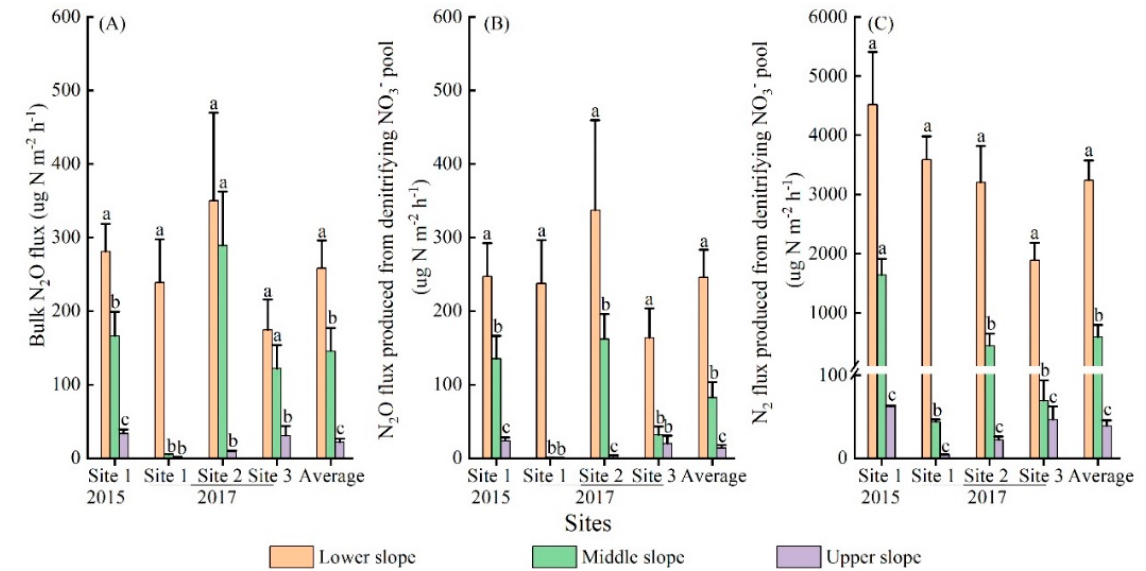
Figure 3. Emission rates of soil bulk N 2 O ( A ), 15 N 2 O ( B ) and 15 N 2 ( C ) with incubation time after in situ 15 NO 3 − addition (2.5 g 15 N m − 2 ) at different slope positions in the mixed forest of Qingyuan sta- tion in Northeast China. V alues from different sites (1, 2, 3) and the overall average are shown.